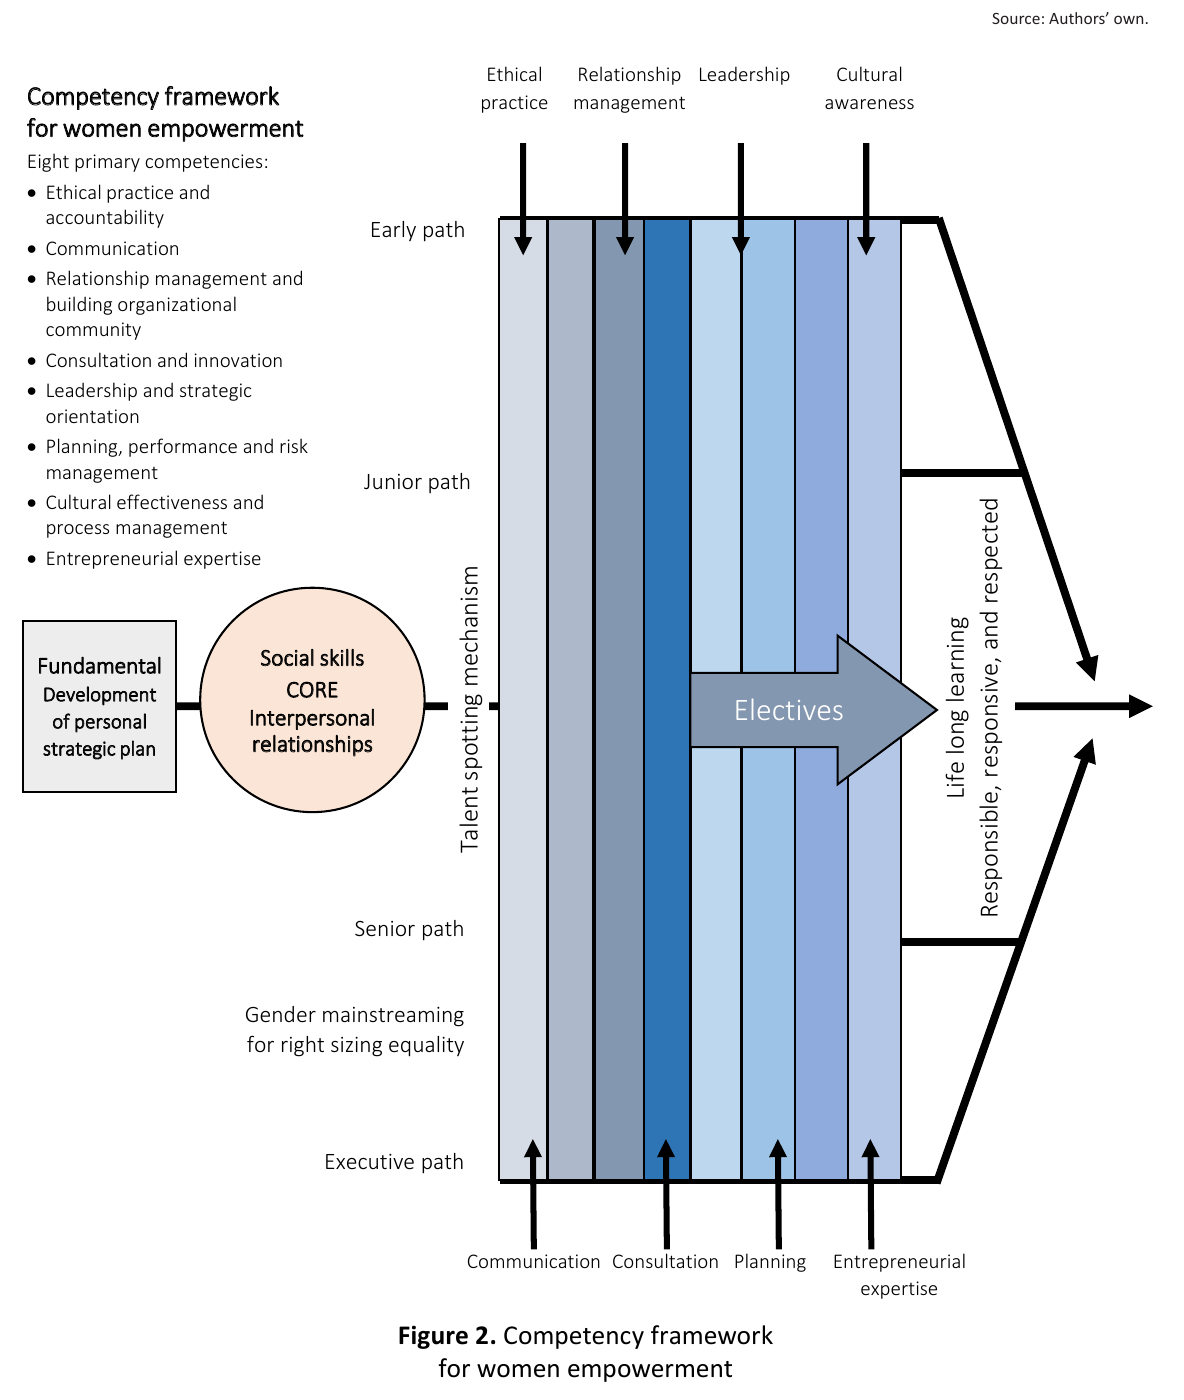
Figure 2 reflects the proposed competency frame- work for women empowerment in local government. This framework should be populated by the respec- tive competencies highlighted by the desktop sur- vey of existing gender-based formal and non-formal programs, as well as the competencies identified by target groups 1 and 2 in the empirical investigation.